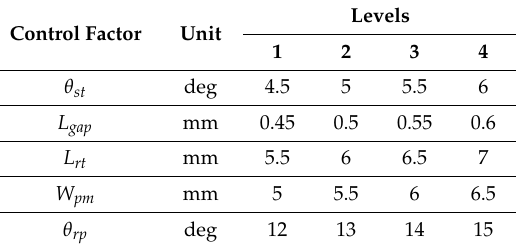
Table 6. Control factors and levels for the FSPMM.